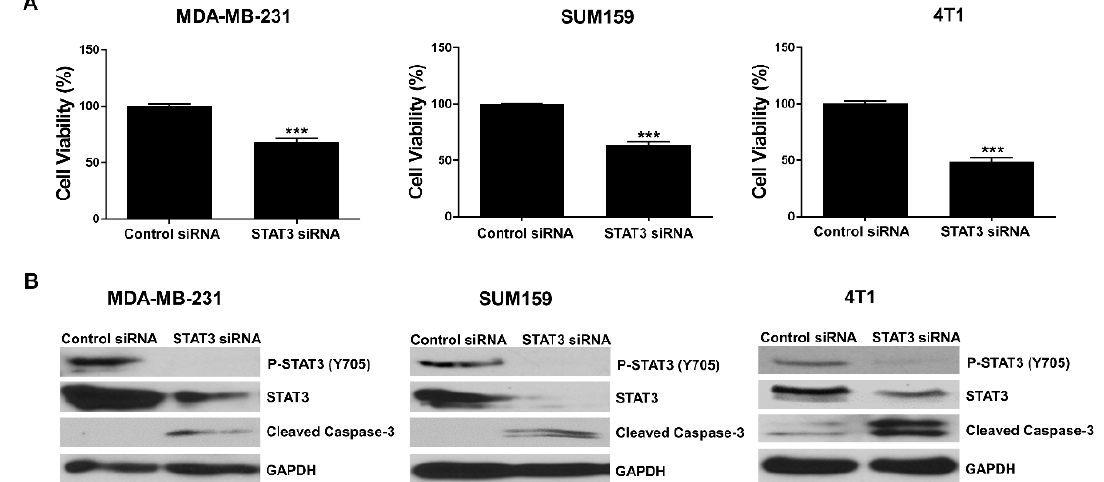
Figure 1. Knockdown of STAT3 inhibited TNBC cell viability. MDA-MB-231, SUM159, and 4T1 cells were transfected with control siRNA and STAT3 siRNA for 72 h and cell viability was evaluated by MTT assay ( A ). The expression levels of P-STAT3 (Y705), STAT3, and cleaved caspase-3 were analyzed by Western blot analysis ( B ). GAPDH served as a protein loading control. *** p < 0.001.